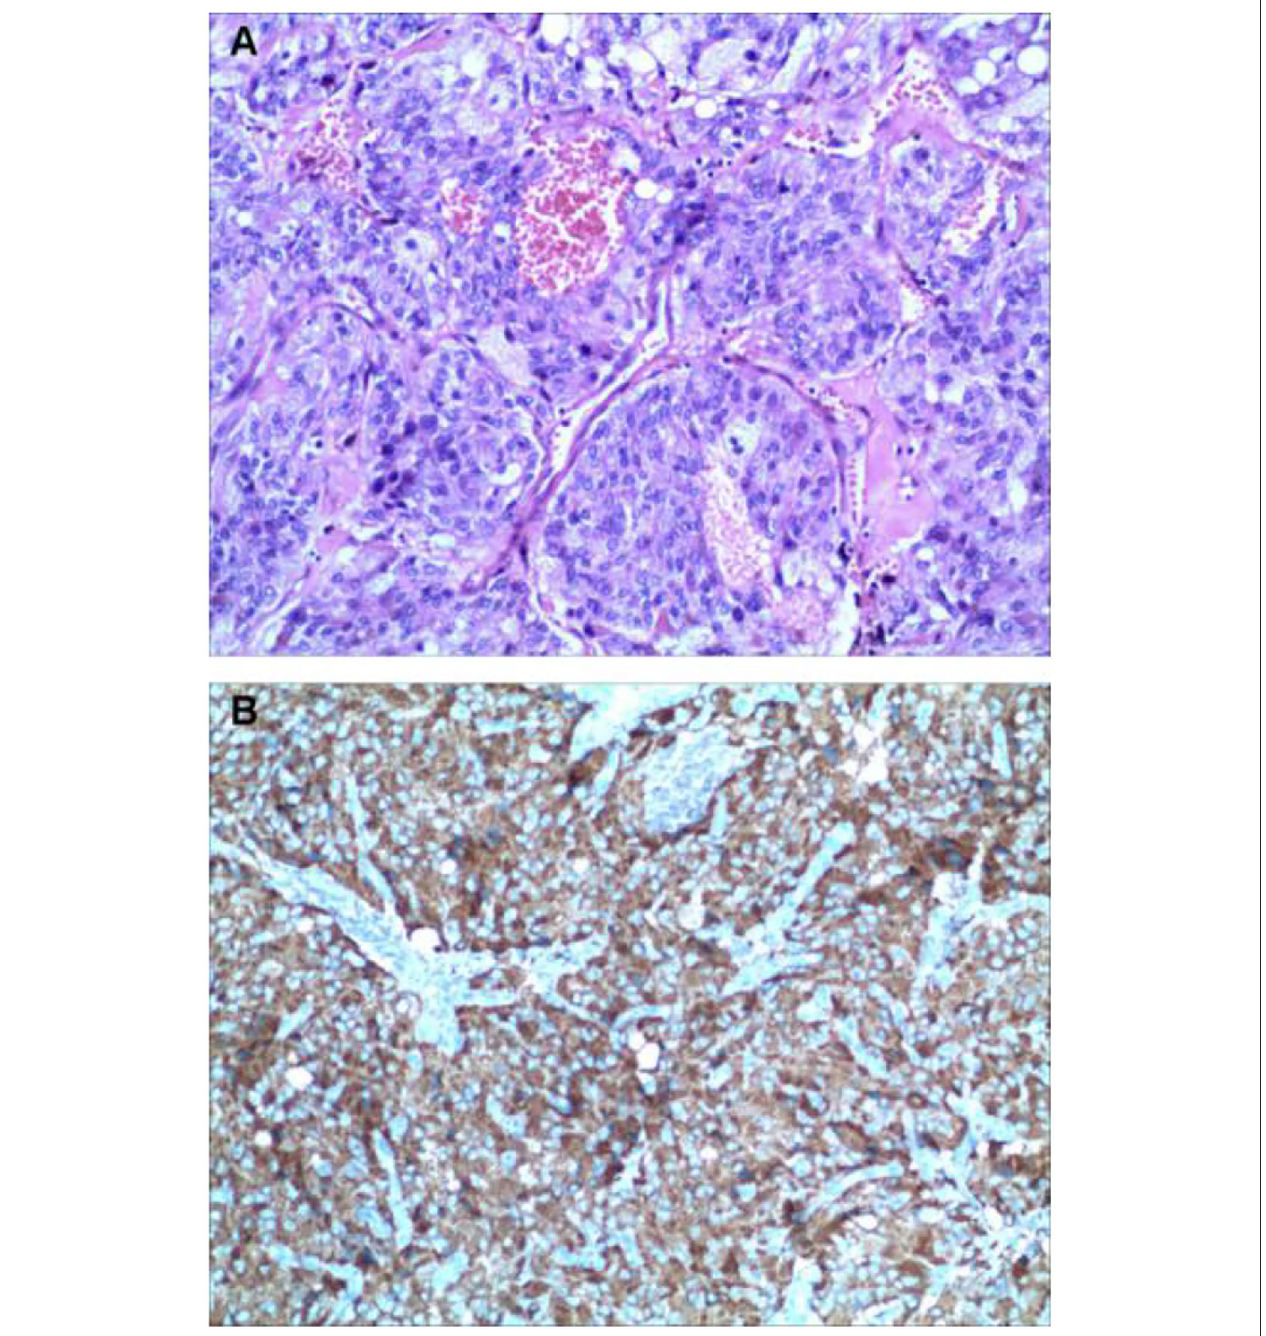
FIGURE 3 | Histologic findings. Histological evaluation of adrenal neoplasms revealed rounded to polygonal cells with abundant granular amphoteric cytoplasm arranged in well-defined nests [ (A) hematoxylin, and eosin]. Immunohistochemical testing shows positive expression of CgA (B) .